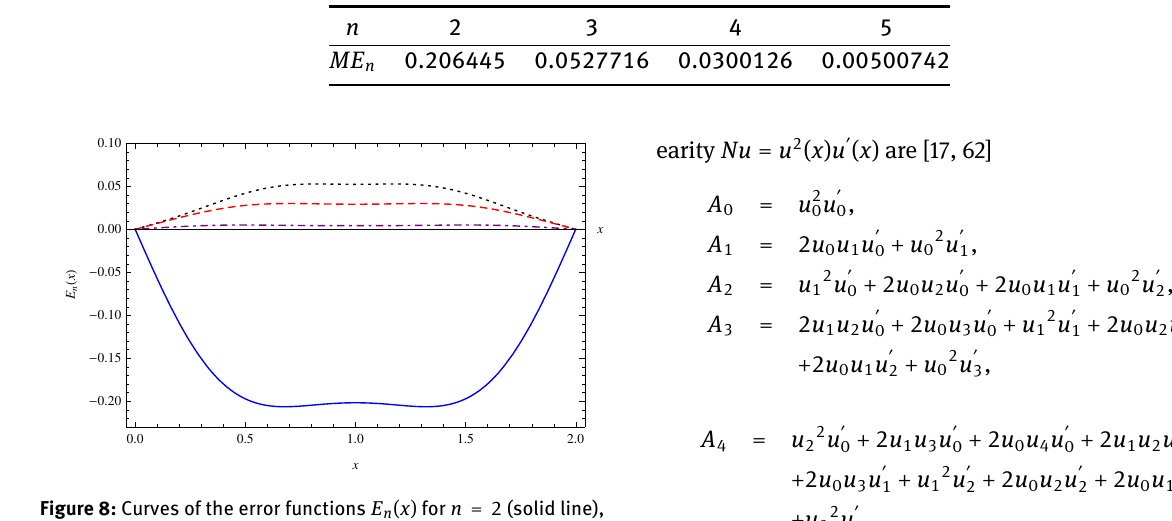
Figure 8: Curves of the error functions E n ( x ) for n = 2 (solid line), n = 3 (dot line), n = 4 (dashed line), and n = 5 (dot-side line).